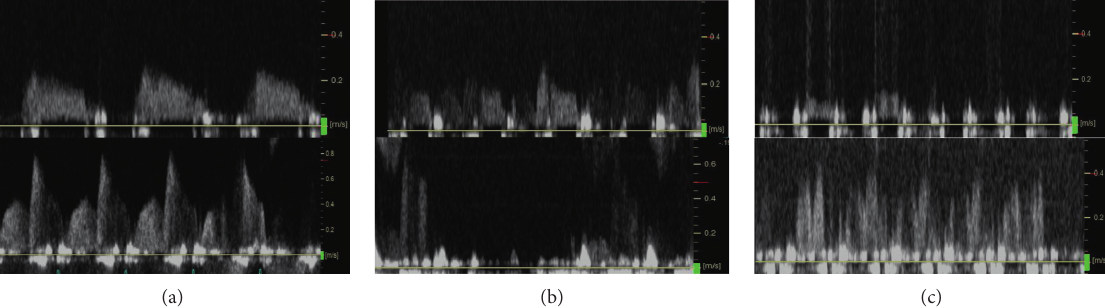
Figure 3: Examples of different qualities of coronary flow velocity curves at rest (upper level) and peak hyperemia (lower level). (a) Well- defined and reproducible flow curves. (b) Blurred and inconsistent flow curves (e.g., due to chest movements). (c) Poorly defined flow curves (e.g., due to probe displacement leading to partial loss of coronary flow signal).